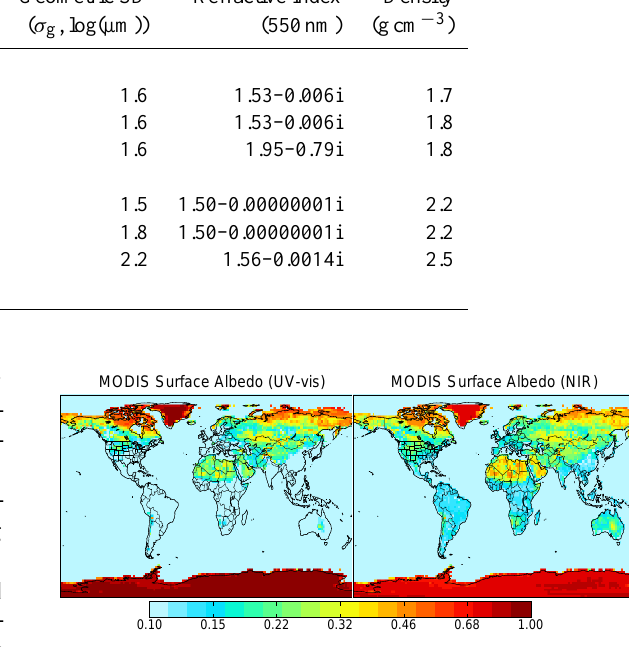
Figure 1. Annual mean surface direct albedo in the UV visible (left) and near infrared (right) from MODIS 2002–2007